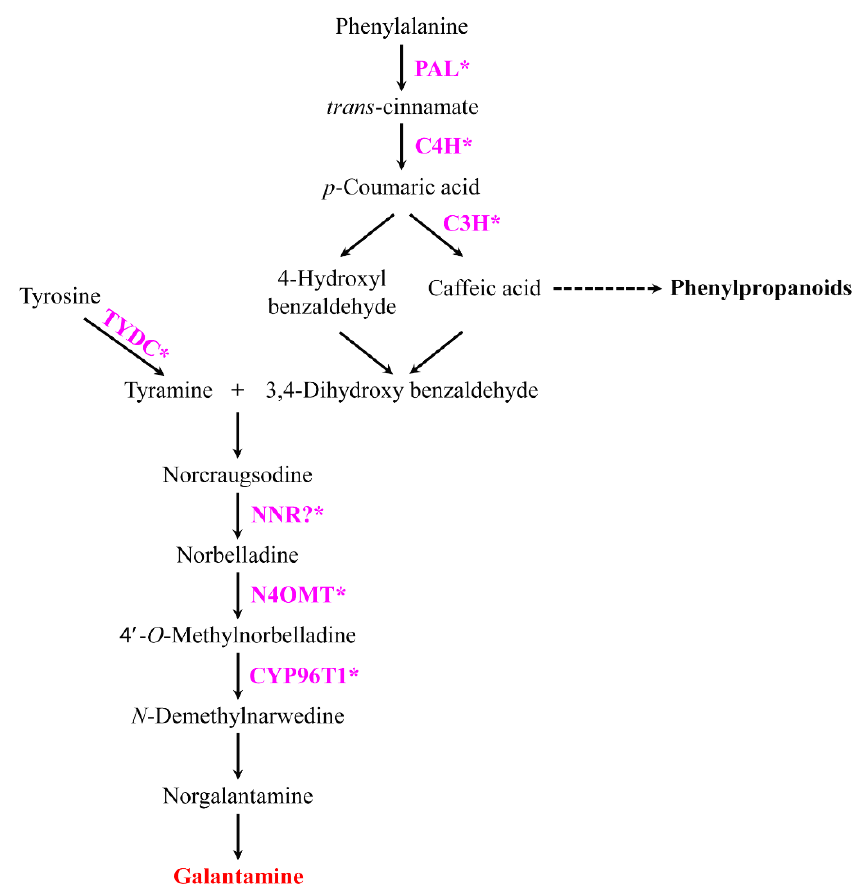
Figure 1. Proposed galantamine biosynthetic pathway in Lycoris radiata . Enzymes involved in each conversion reaction are indicated in pink. Asterisks indicate the genes used in expression analysis. Galantamine content measured using high-performance liquid chromatography is indicated in red.